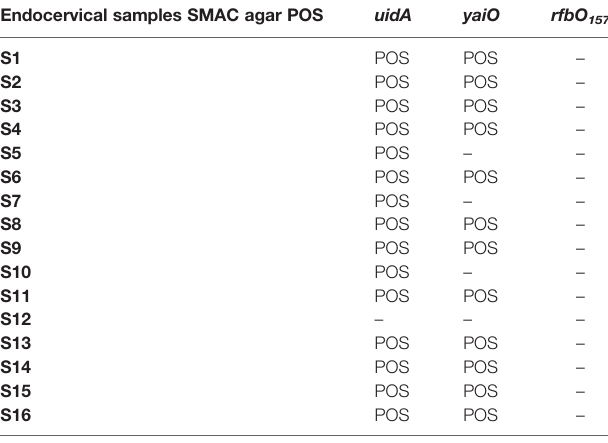
TABLE 3 | Genotypic characterization of E. coli in endocervical samples grown on SMAC